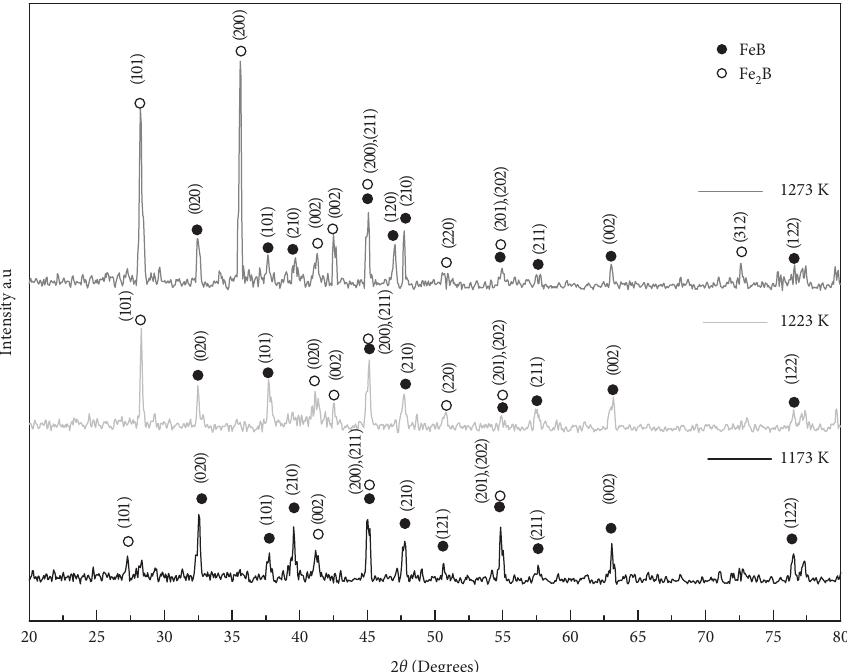
Figure 7: X-ray difraction patterns of AISI 8620 steel borided at 1173K, 1223K and 1273K for